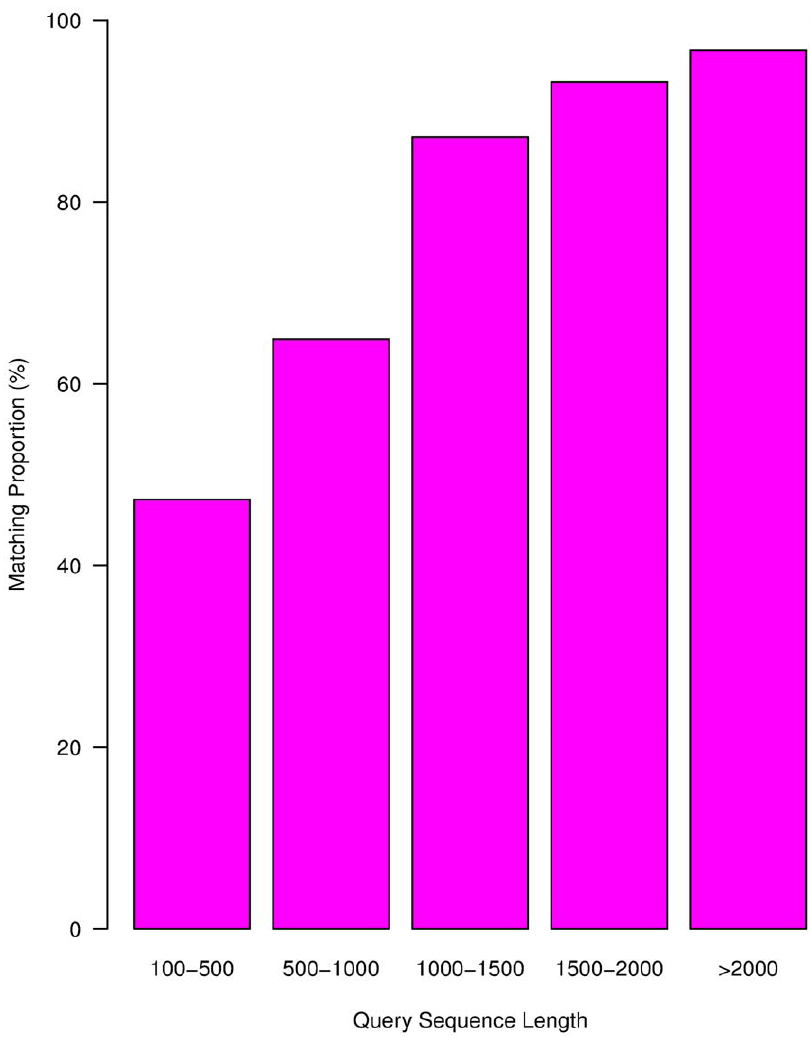
Figure 1. Matching percentage of D.latiflorus cDNA sequences with different lengths to entries in the GenBank databases.